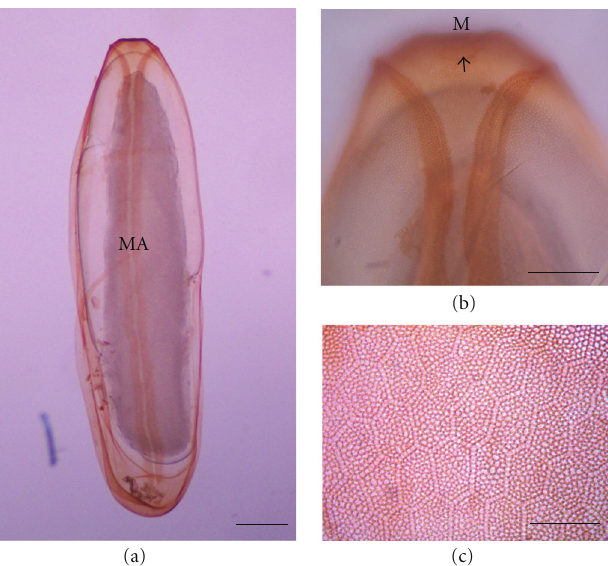
Figure 1: Egg of Hemipyrellia ligurriens stained with 1% potassium permanganate. (a) Whole egg; MA: median area. (b) Anterior end of egg showing bifurcated plastron and micropyle; M: micropyle. (c) External chorionic sculpture showing hexagonal pattern, with its reticular boundary slightly elevating like a net. Bars = 100 µ m for all figures.